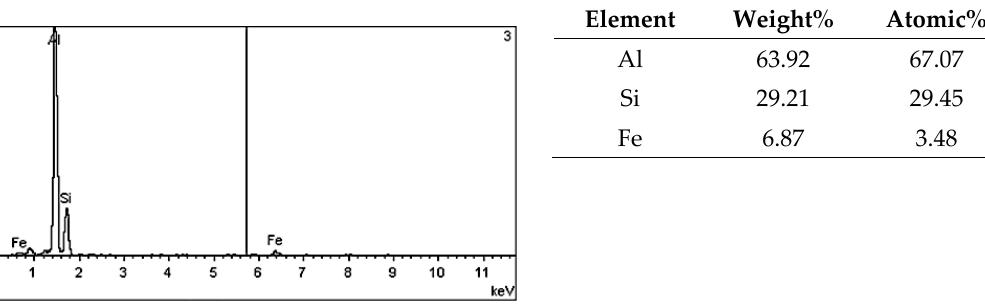
Figure 8. EDS diagram and chemical composition at point no. 3 of Figure 5.